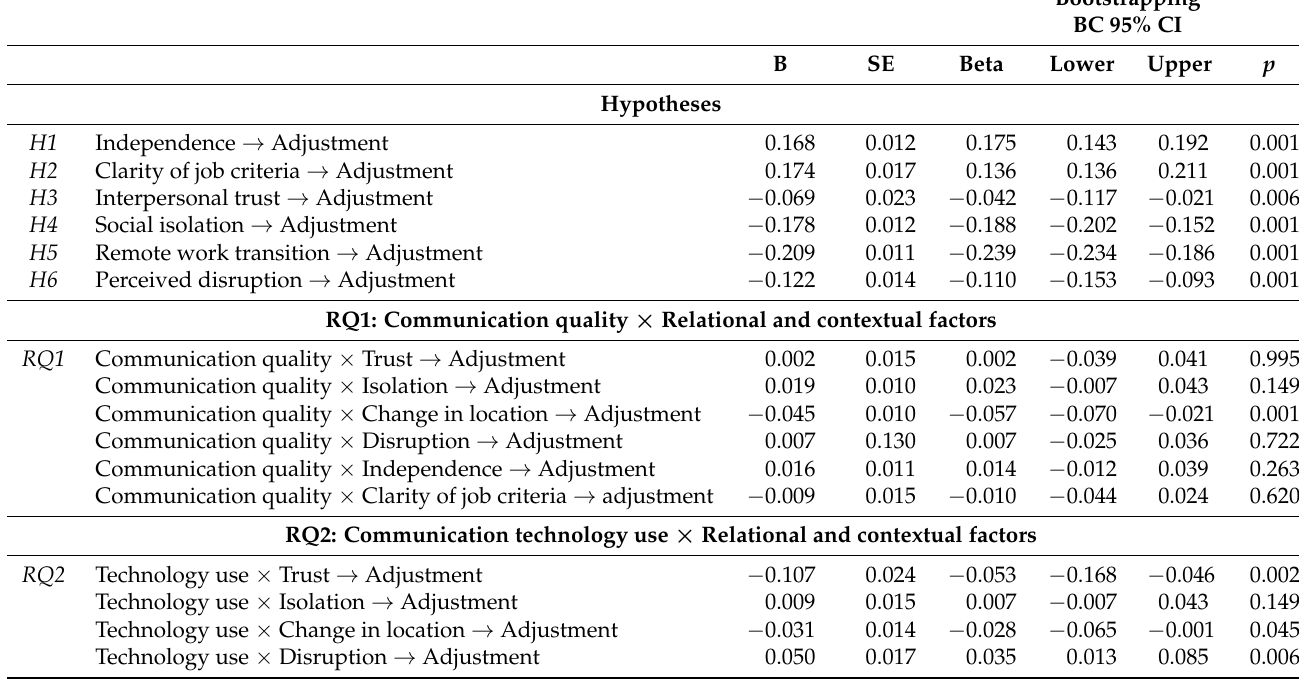
Table 3. Parameter estimates of path